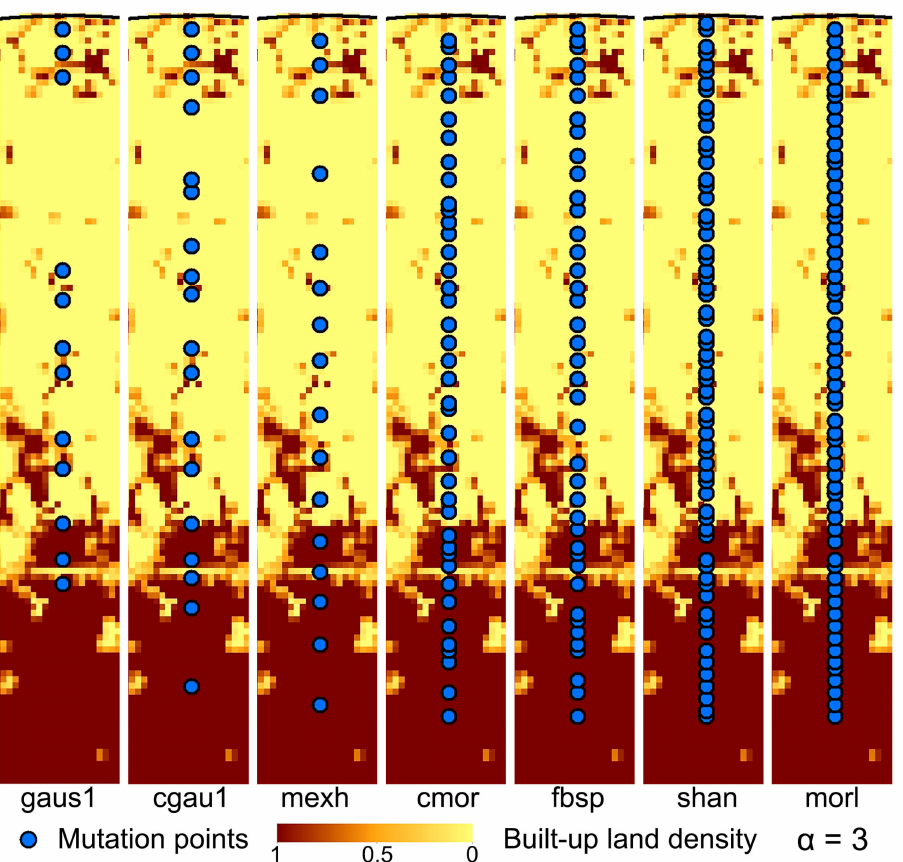
Figure 4. Extraction results with different wavelet functions (taking the built-up land density of the 0 ◦ transect as an example).